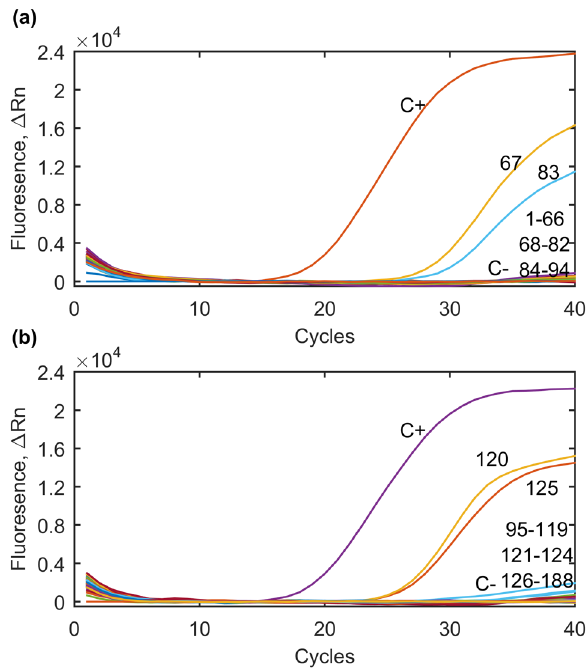
Figure 1. Results of the Toxoplasma gondii DNA detection in water samples collected from the area of Qinghai Province, P.R. China using real-time PCR. A) Results of real-time PCR performed for samples 1-94; C+- T. gondii positive control, 67-positive wastewater sample (template No. 67), 83-positive wastewater sample (template No. 83), C--negative control. B) Results of real-time PCR performed for samples 95-188; C+- T. gondii positive control, 120-positive wastewater sample (template No. 120), 125-positive wastewater sample (template No. 125), C--negative control. Figure was prepared using MATLAB R2015a.